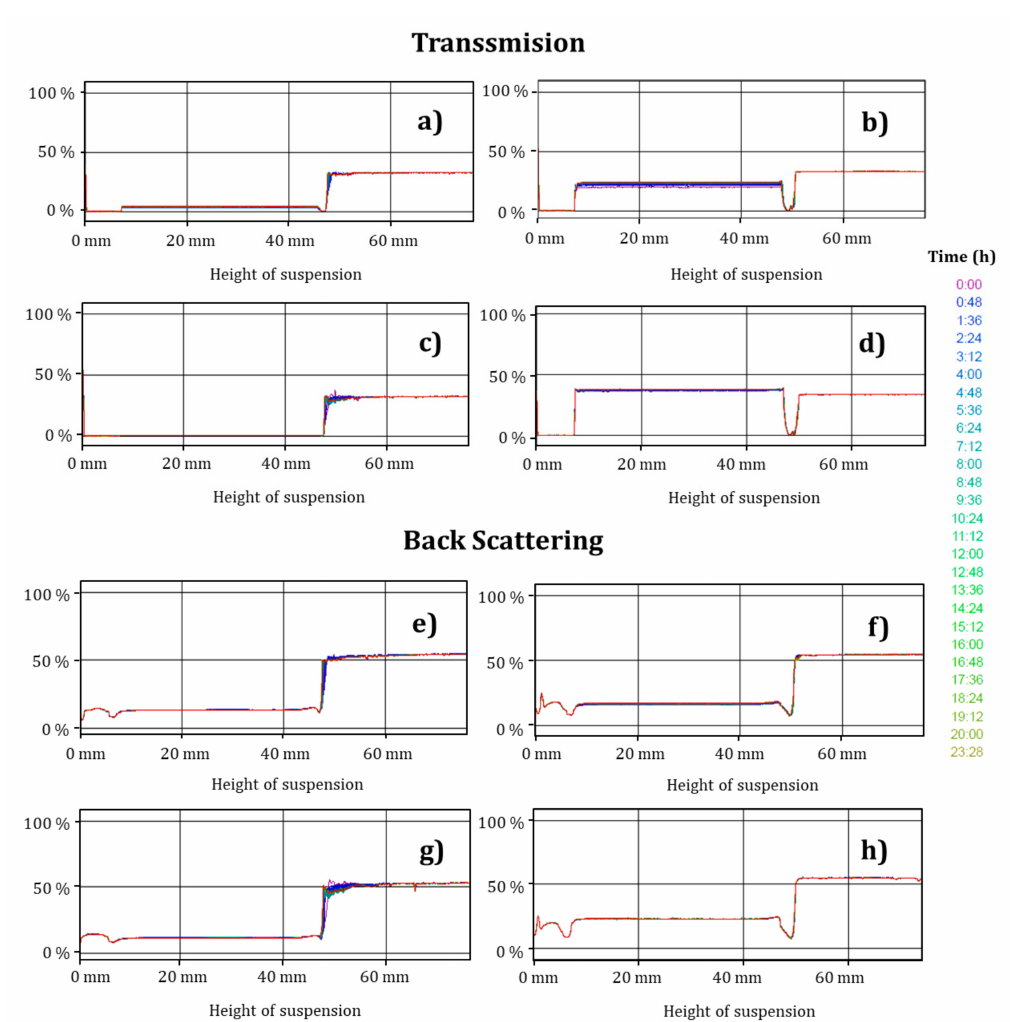
Figure 6. Di ff use reflectance: ( a ) and ( e ) ETC-PVA; ( b ) and ( f ) ETC-Pluronic ® F-127; ( c ) and ( g ) PCL-Pluronic ® F-127; and ( d ) and ( h )